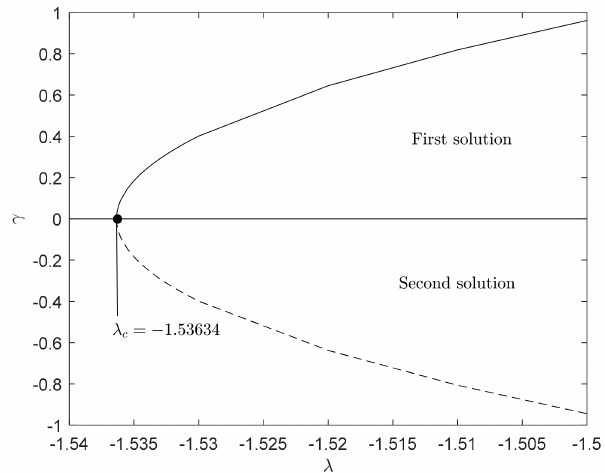
Figure 13. Smallest eigenvalues γ with λ when ϕ 1 = ϕ 2 = 0.01, β = 0.2 and M =